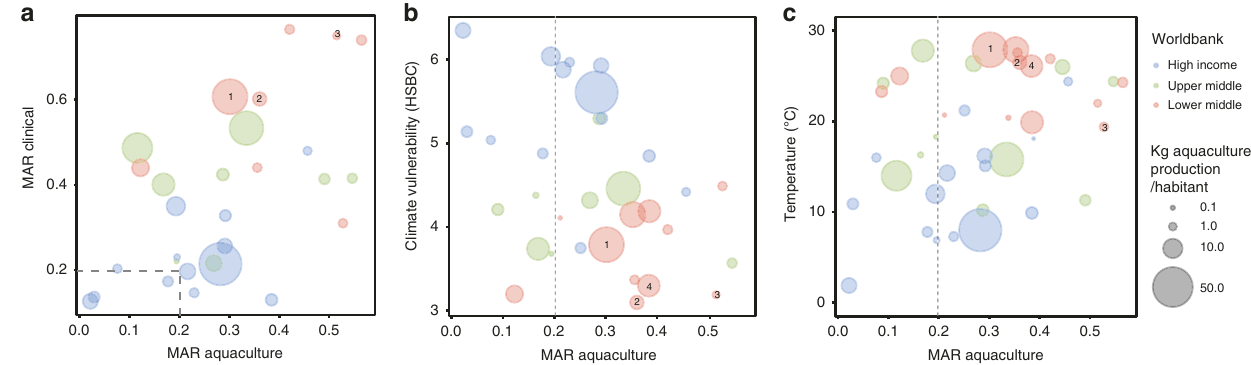
Fig. 3 Correlations between MAR calculated from aquaculture-related bacteria and human clinical bacteria, temperature, and countries ’ climate vulnerability. Pearson correlations (two-sided test) a MAR from human clinical bacteria ( n = 29, P -value < 0.001), b HSBC climate vulnerability index ( n = 32, P -value = 0.020) and c temperature ( n = 40, P -value 0.10). Bubbles sizes are proportional to national aquaculture production standardised by the total country human population. The colours indicate different Worldbank categories (High income, Upper-middle income and Low-middle income). 1: Vietnam, 2: India, 3: Pakistan, 4: Bangladesh displayed simultaneously the highest levels of clinical and aquaculture MAR and are among the ones exposed to the highest climatic vulnerability and temperatures rises. See the Methods section